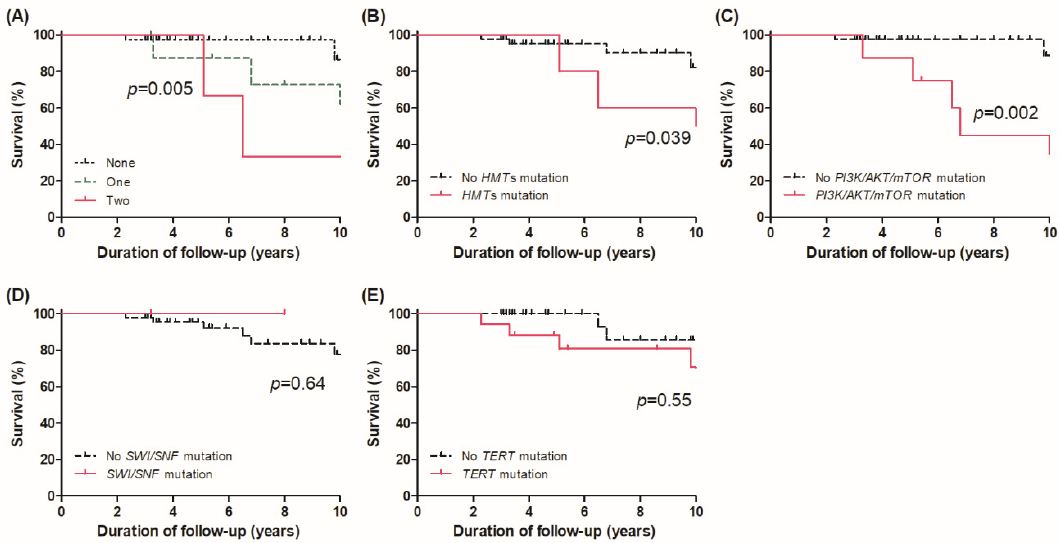
Figure 3. Overall survival curves according to ( A ) the number of mutation sites in functional groups, presence of mutations in ( B ) HMTs, ( C ) PI3K/AKT/mTOR pathway, ( D ) SWI/SNF chromatin remodeling complex, and ( E ) TERT promoter.